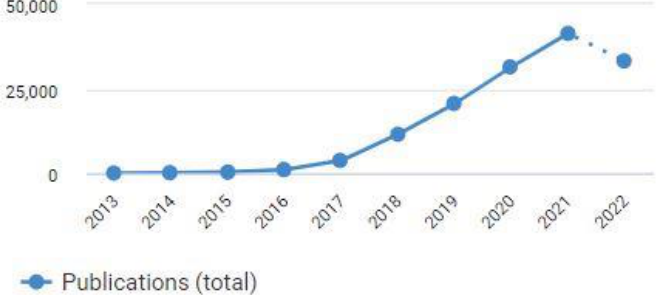
Figure 1. Trend of research publication with Blockchain technology (From 2013 to September 2022).